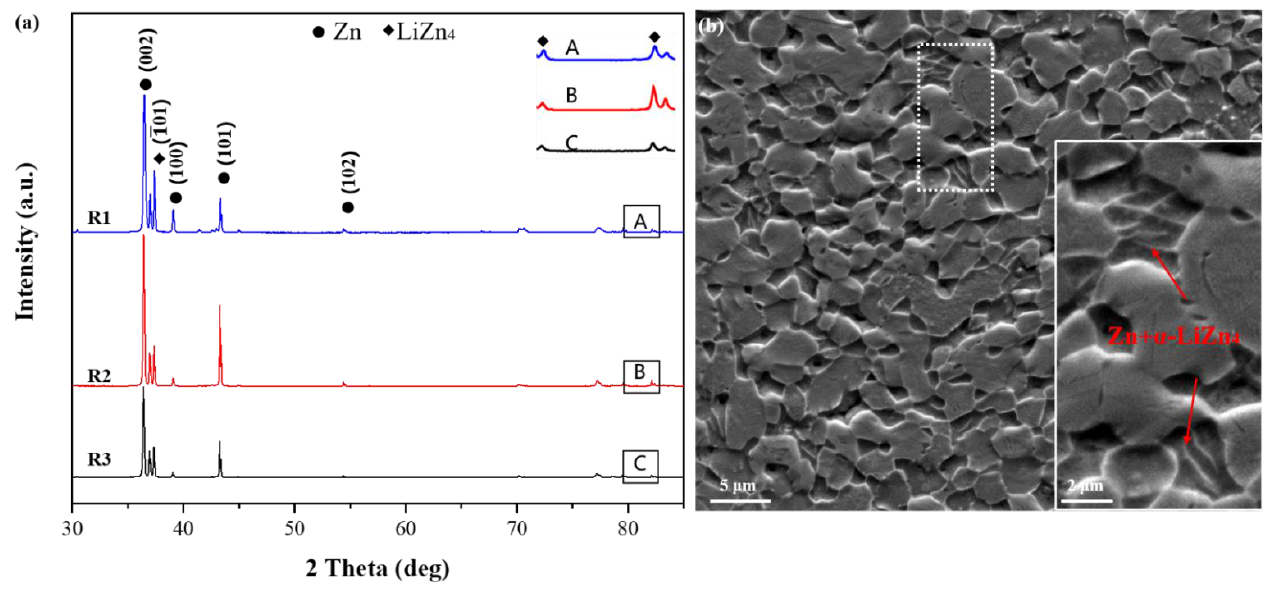
Figure 2. ( a ) XRD spectra of Zn-0.45Li alloys and ( b ) SEM image of the R1 alloy.